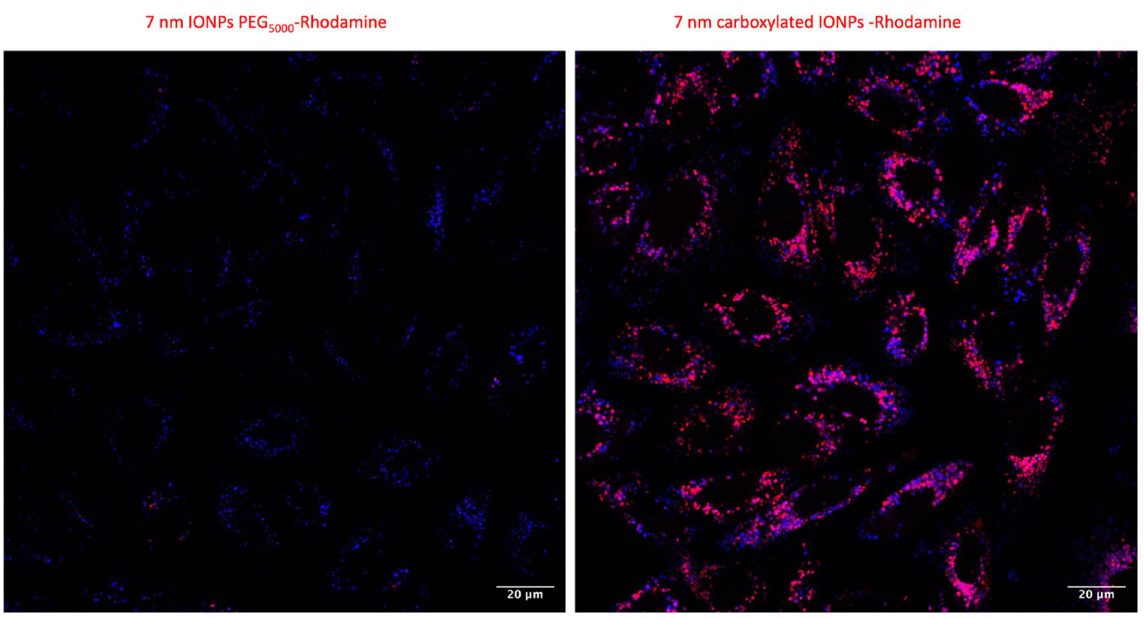
Figure 3. Confocal microscopy micrographs of iron oxide nanoparticle uptake in A549 cells and intracellular localization. Cells preincubated with 7 nm IONPs PEG 5000 ( left ); 7 nm carboxylated IONPs ( right ) ([Fe] = 50 μg.mL –1 ) for 48 h (scale bar: 20 μm). Red channel: Rhodamine-IONPs and Blue channel: LysoTracker Blue.